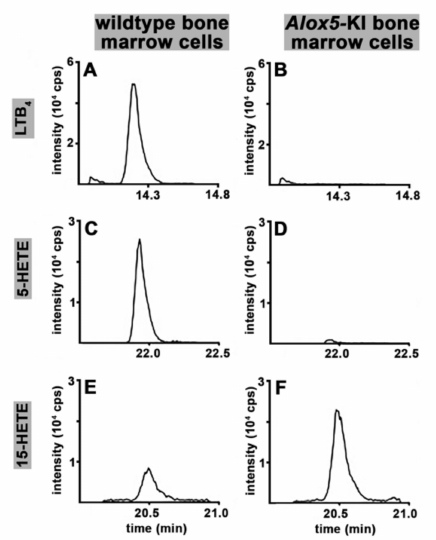
Figure 4. Ex vivo Alox activity assays of bone marrow cells prepared from Alox5 -KI mice and corresponding wildtype controls using endogenous substrates. Pooled bone marrow cells of either Alox5 -KI mice ( n = 5; panels B , D and F ) or WT-mice ( n = 3, panels A , C and E ) were used. For each assay 2 × 10 7 cells were reconstituted in 0.5 mL PBS and were incubated at room temperature in the presence of 5 µ M calcium ionophore A23187 for 5 min. Total lipids were extracted (ethyl acetate), solvent was evaporated, the remaining lipids were reconstituted in 50 µ L methanol and analyzed for LTB 4 (panels A , B ), 5-HETE (panels C , D ) and 15-HETE (panels E,F ) by LC-MS/MS. Chromatographic separation of lipid extracts was carried out using a Zorbax Eclipse Plus C18 RP-column (Agilent, Waldbronn, Germany) and for MS/MS detection the QTRAP instrument (Sciex, Darmstadt, Germany) was operated in negative electrospray ionisation mode. Shown are SRM traces of cell extracts for LTB 4 ( m/z 335.2 → 195.1), 5-HETE ( m/z 319.2 → 115.2) and 15-HETE ( m/z 319.2 →